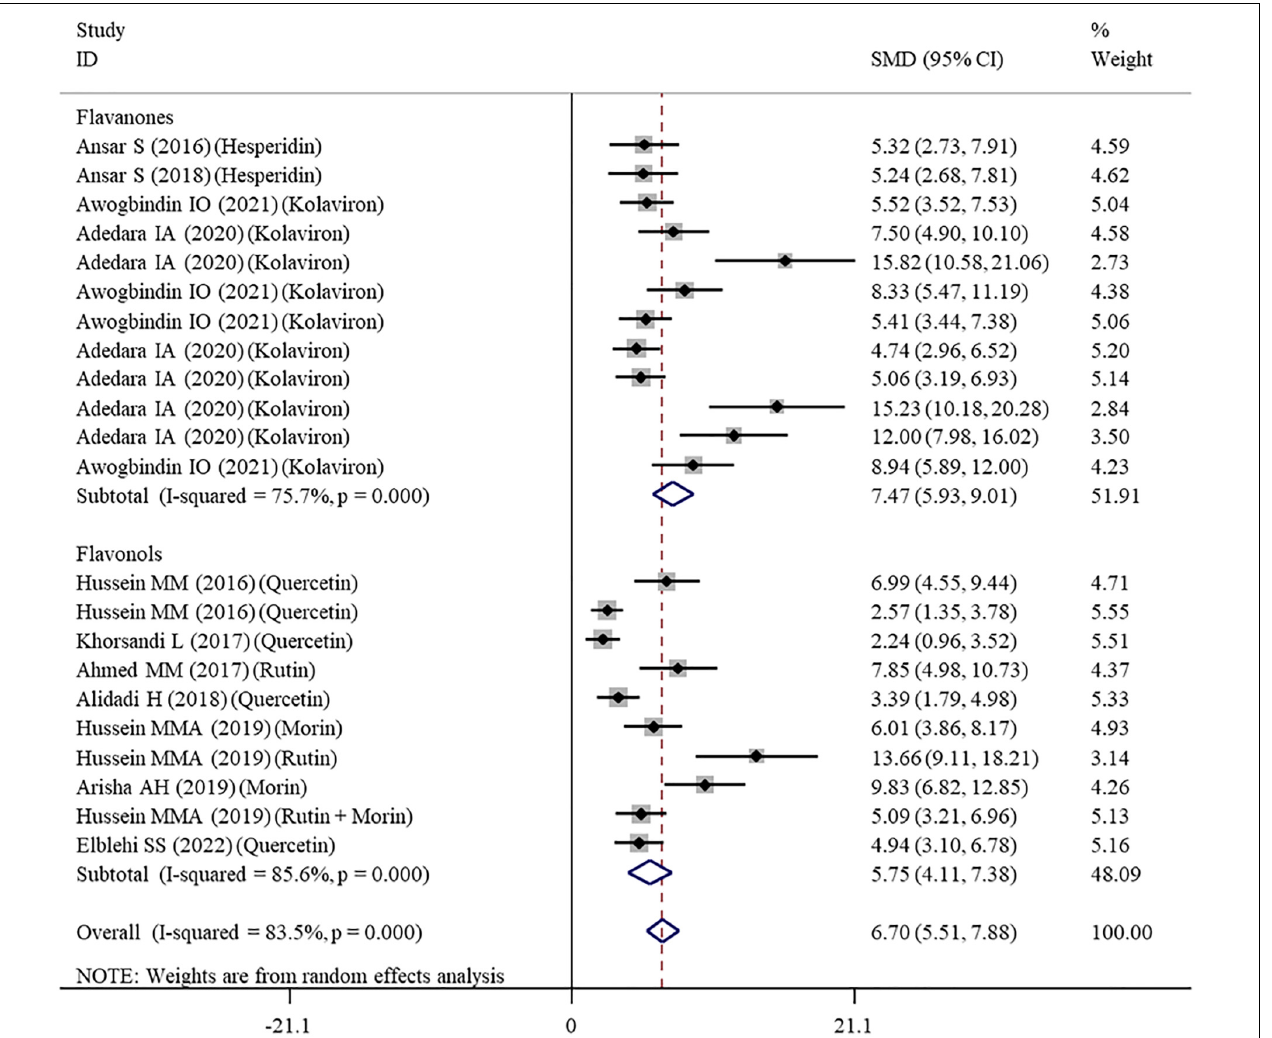
FIGURE 4 | Forest plots to show the effects of flavonoid supplementation on CAT levels compared with the nanomaterial exposure group. CAT, catalase; SMD, standardized mean difference; CI, confidence interval.